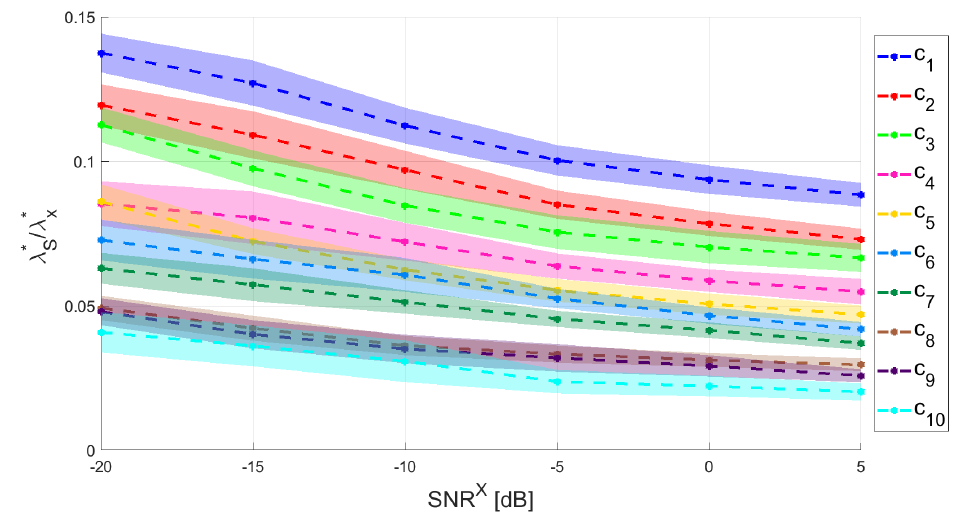
∗ S ) as a function of SNR X . Different colors λ ∗ x